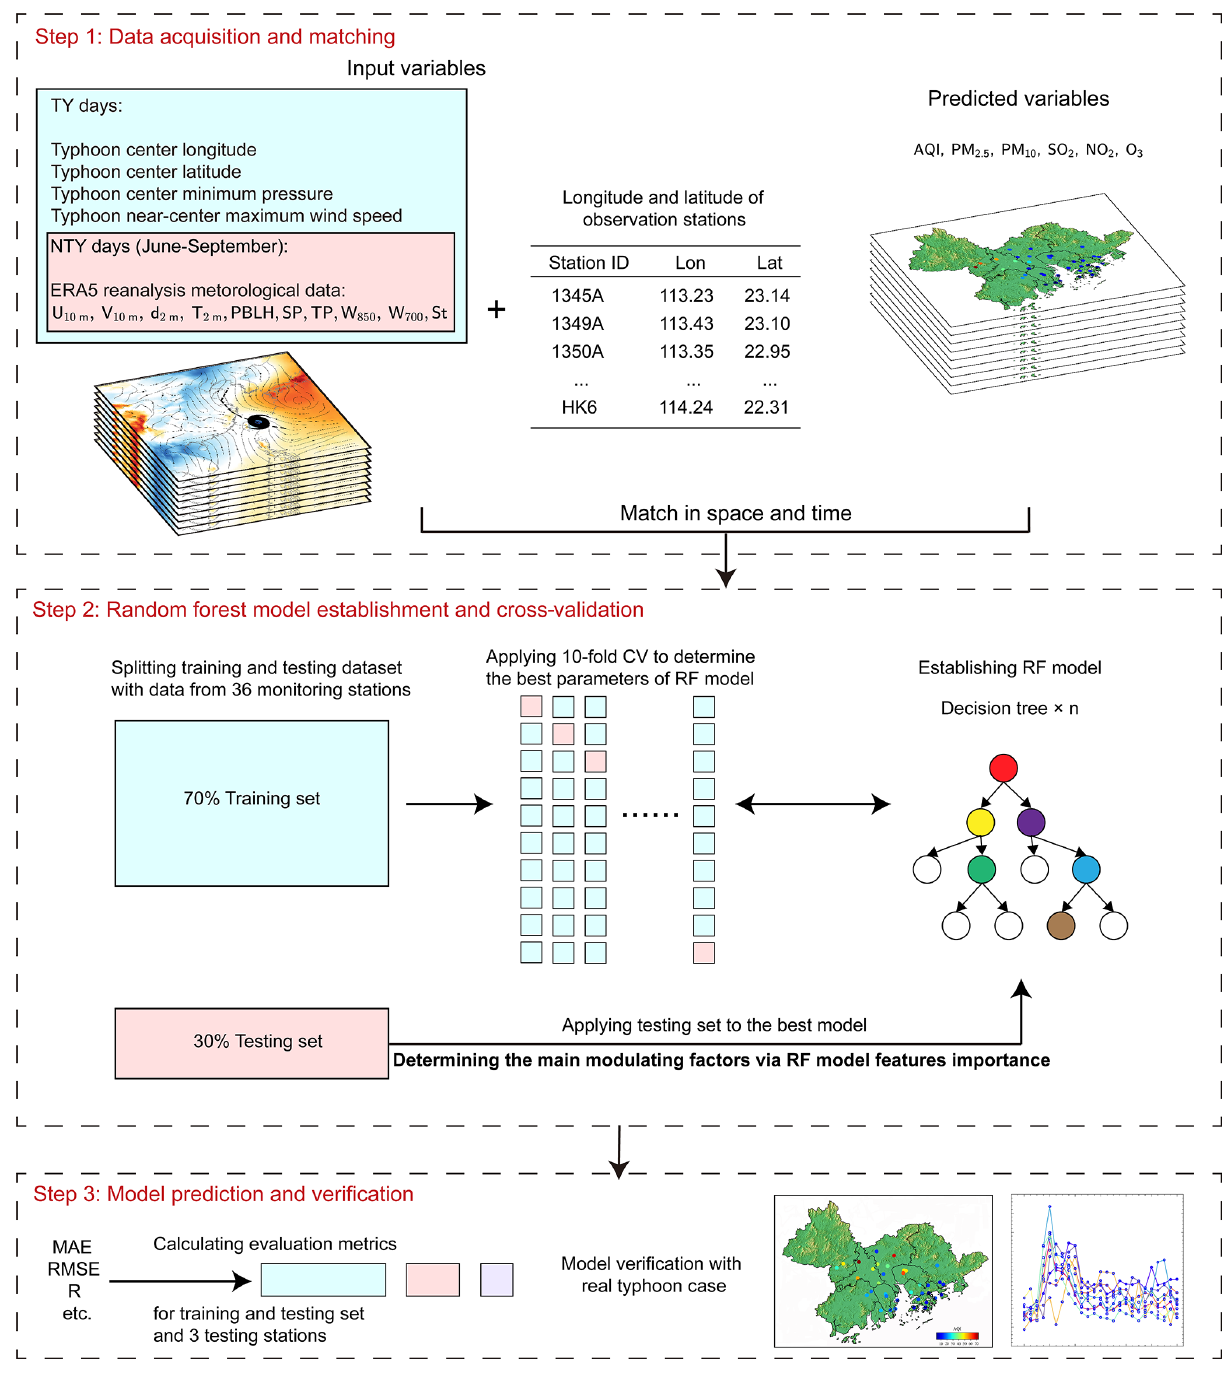
Figure 2. Flow chart of the study framework.